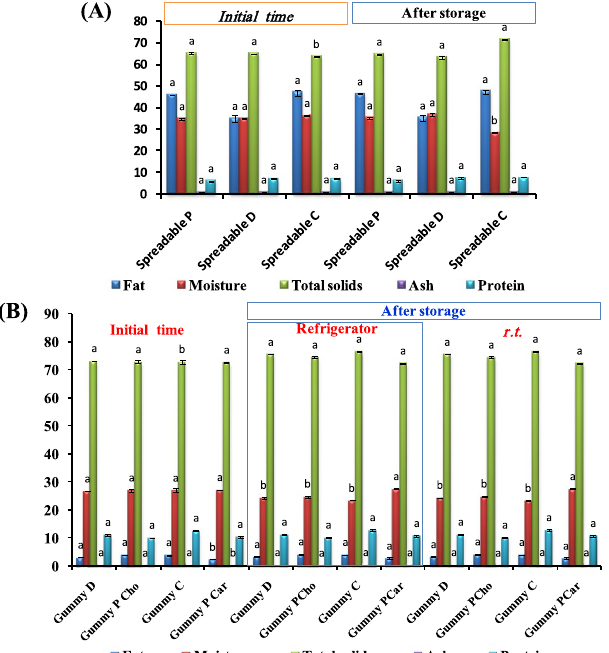
Figure 2. Chemical analysis of ( A ) functional spreadable oleogel and ( B ) healthy nutritional gummy formulations. Columns with similar letters are not statistically different according to DMRT (p ≤ 0.05). Statistical analysis was performed to determine the significance at the initial time and after storage.